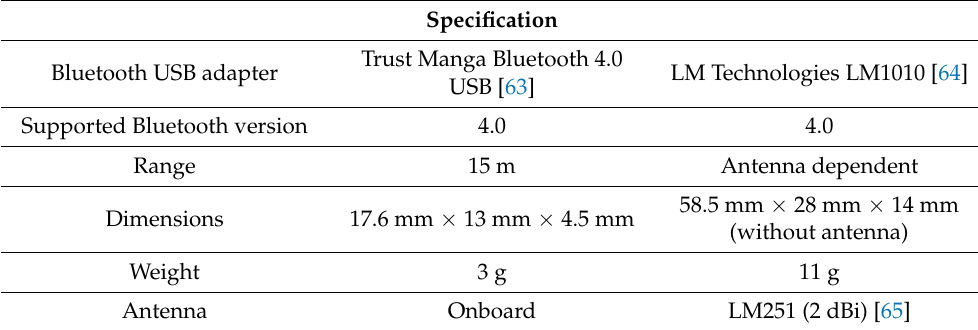
Table 2. Bluetooth USB adapter specifications.